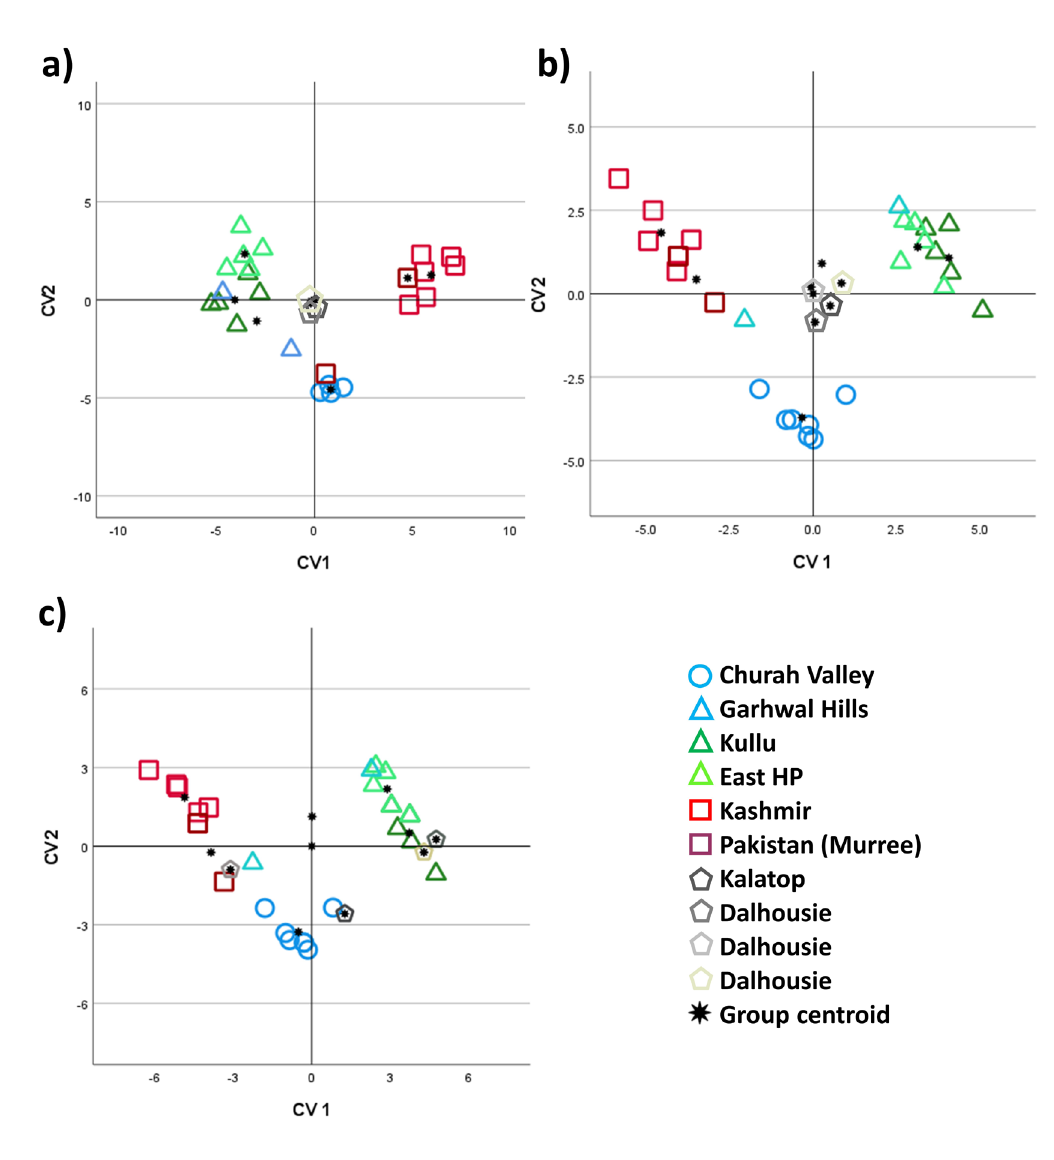
Fig. 6. Canonical Variate analysis of Gloydius himalayanus (Günther, 1864) morphological data. Different analyses represent different combinations of characters and specimens as described in the text, a trade-off required by the presence of missing data. a . More characters, fewer specimens (n = 24): the main discriminating characters on CV1 are Supoc (with lower counts at more positive values), 14to12SC, 12to10SC and 8to6SC (occurring more posteriorly at more positive values) and on CV2 are Latgular, Strtemp, Supoc (with higher counts at more positive values). b . Intermediate number of characters and specimens (n = 27): the main discriminating characters on CV1 is Supoc (with higher counts at more positive values), and on CV2 are Latgular, Stripe, Supoc (with higher counts at more positive values) and Stripe and Sublab (with higher counts at more negative values). c . More specimens, fewer characters (n = 31): the main discriminating characters on CV1 is Supoc (with higher counts at more positive values), and on CV2 are Latgular and Strtemp (with higher counts at more positive values). This analysis requires a priori groups to be defined; however, Dalhousie/Kalatop specimens were plotted onto axes extracted using all other groups. In these analyses, CV1 and CV2 summarise 82, 85, and 95% of the variation present, respectively, with CV1 representing ca 60% in all